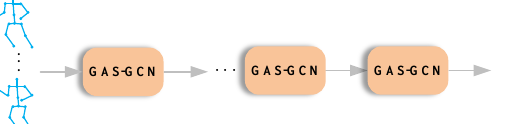
Figure 5. The architecture of the proposed method. The cascaded GAS-GCN is adopted in the proposed method. The input of the networks are skeleton data. At the end of the networks, FC layer is utilized to produce the classification score.